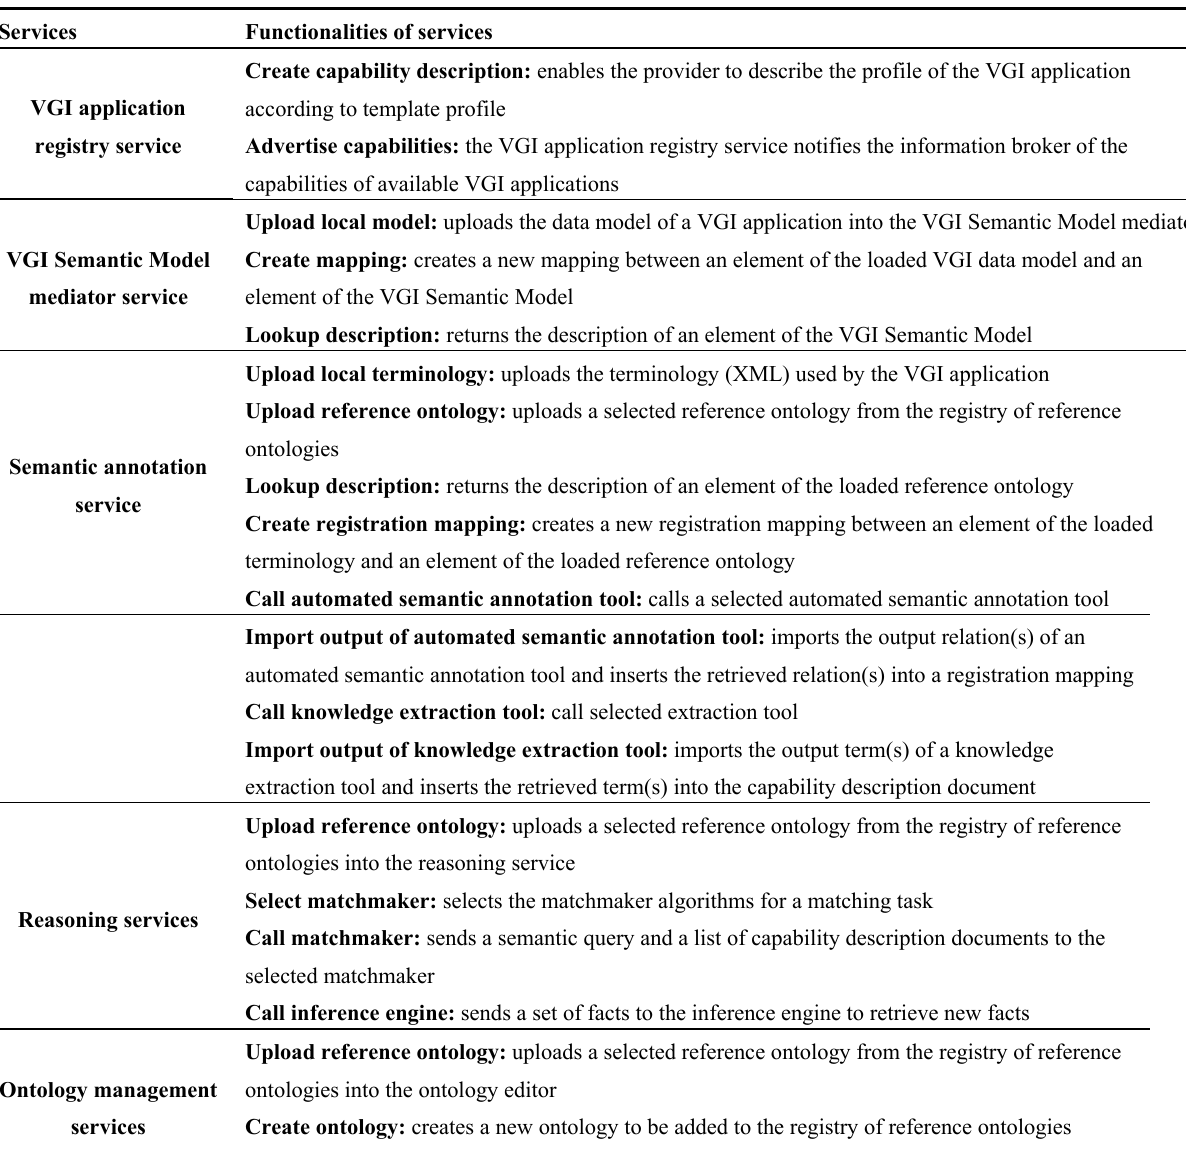
Table 3. Services and functionalities required for the implementation of the